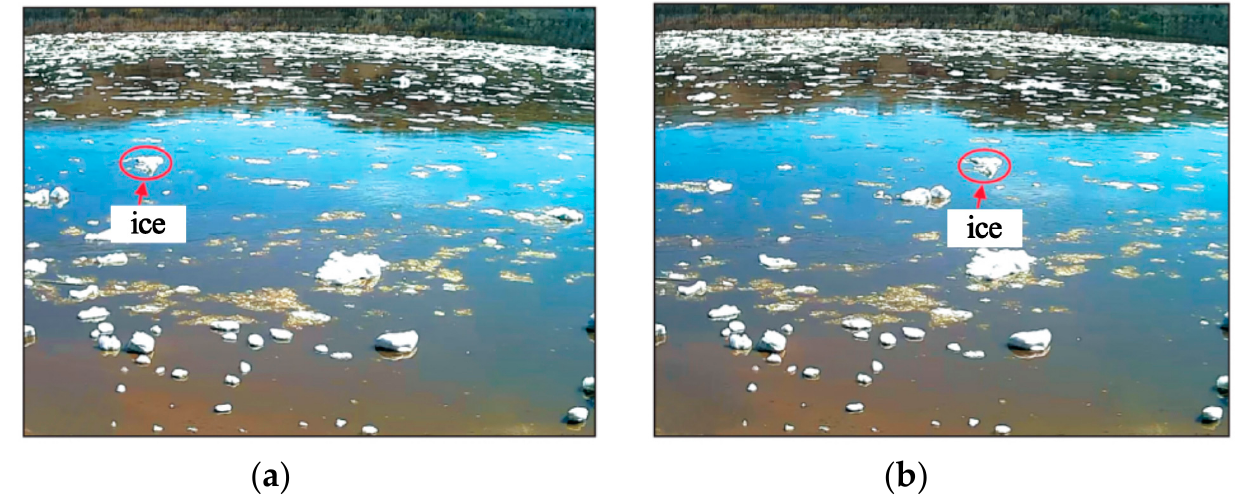
Figure 11. Manual extraction of ice position: ( a ) original position of target ice at 10:28 on 2 May 2016; ( b ) position of target ice after 10 s [13].